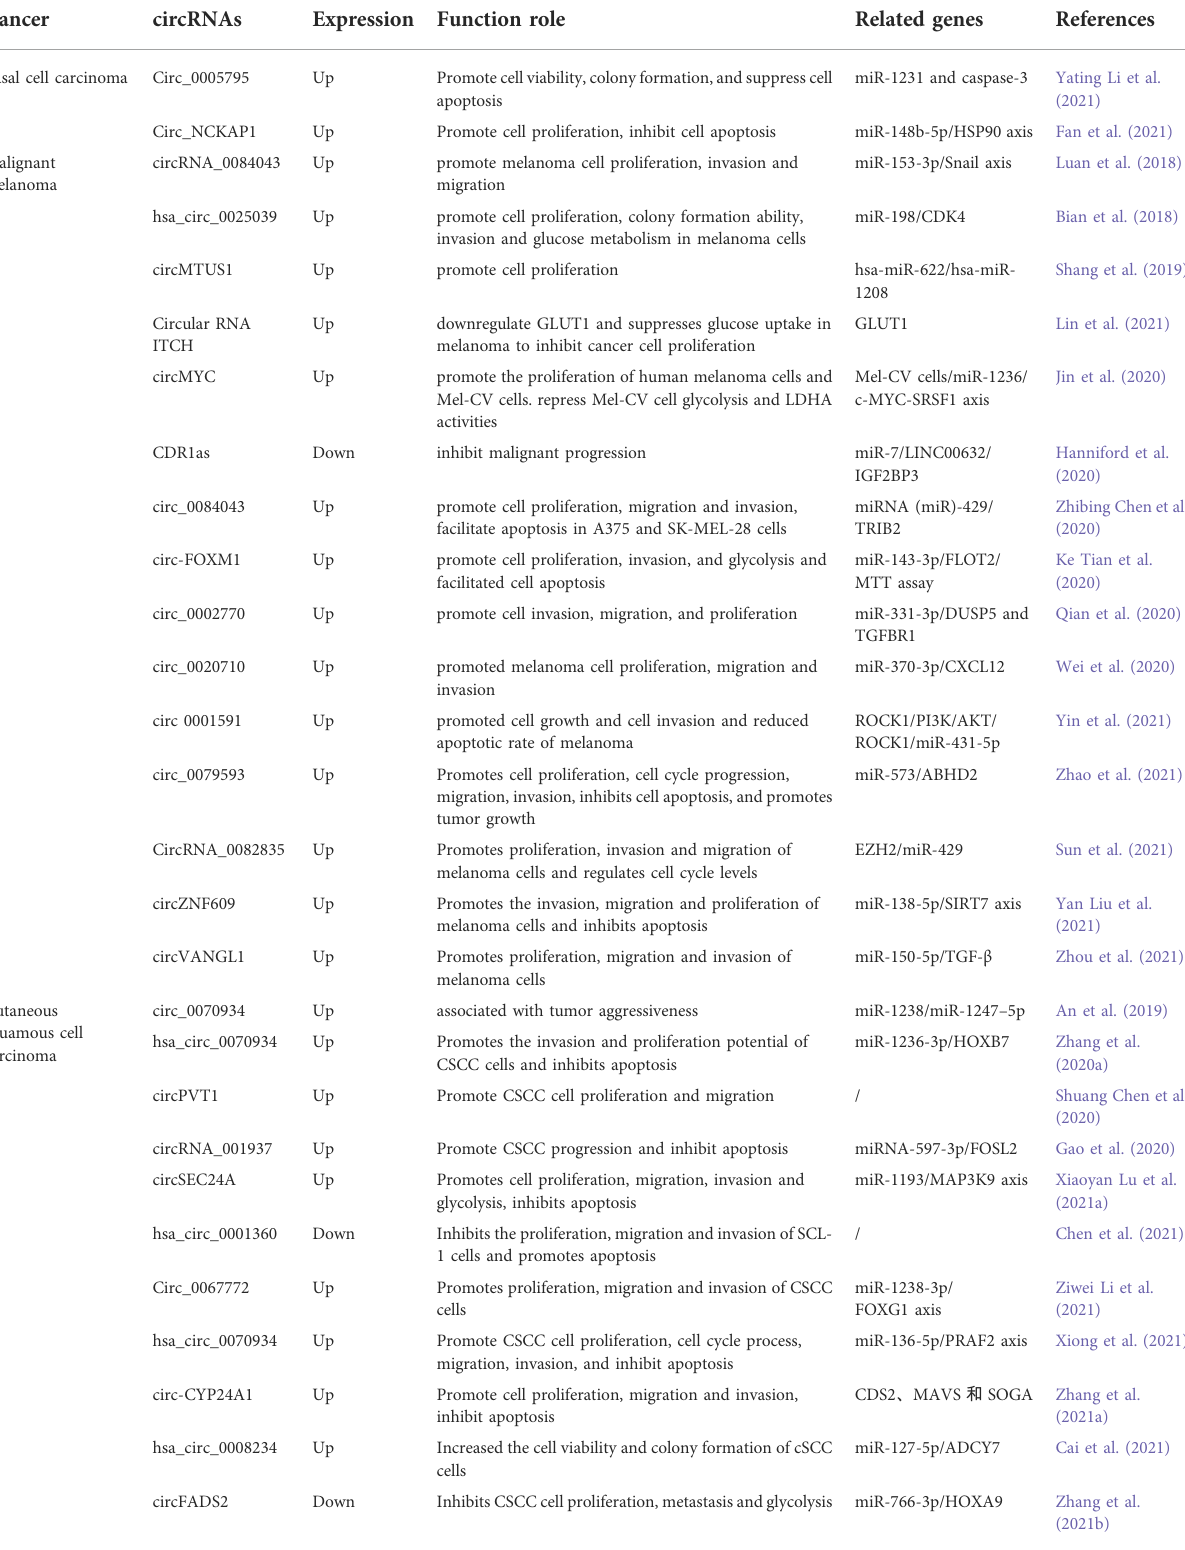
TABLE 7 Functional characterization of circRNAs in skin